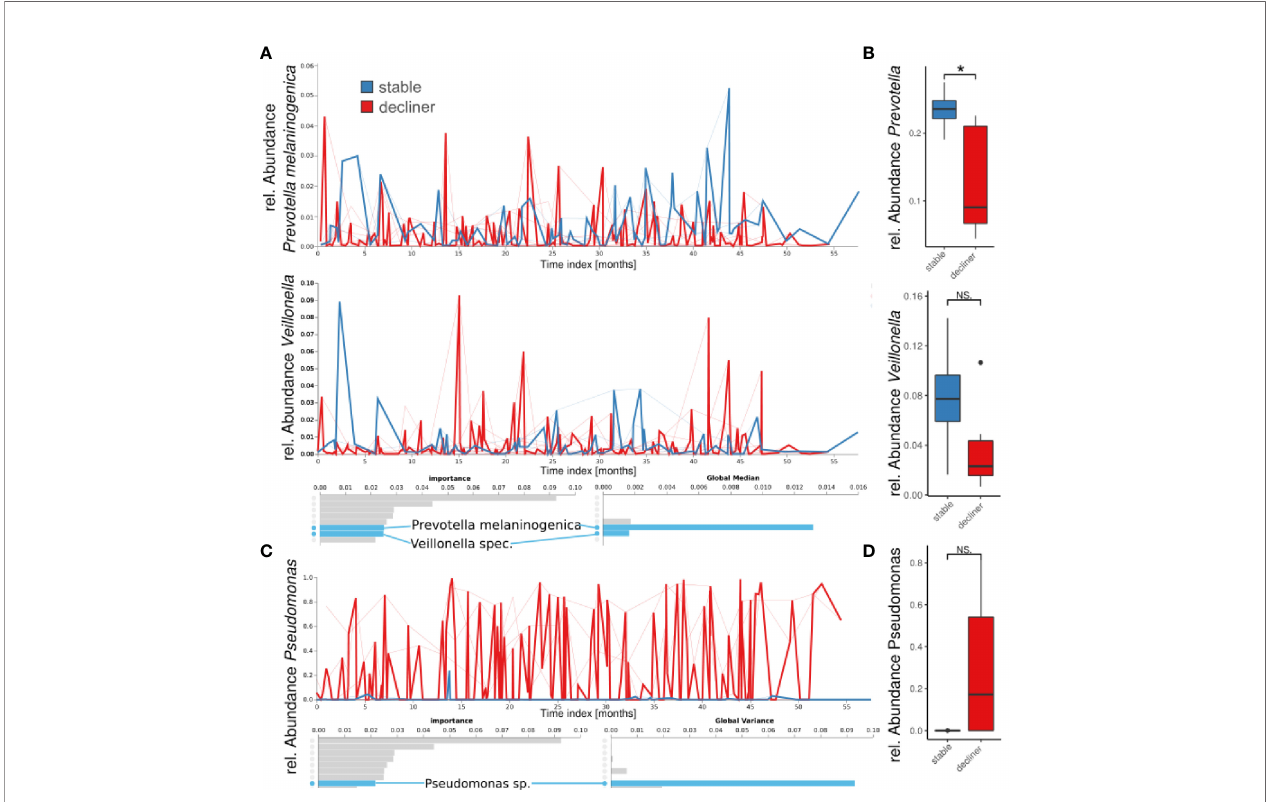
FIGURE 3 | Longitudinal feature volatility analysis on ASV level (A, C) and boxplot visualization (B, D) grouped by patient groups. The feature volatility analysis was done on ASV levels, and the boxplots are median values for each patient for all species with the respective genus name. (A, B) Shown are two examples of important commensals ( Prevotella and Veillonella ), which do also reveal a high global median in the feature volatility analysis. (C, D) A Pseudomonas ASV is the eighth important feature (ASV), but the fi rst with a very high global variance indicates a high impact on the microbiome development, and it is important for distinguishing between patient groups. *p < 0.05), NS, not signi fi